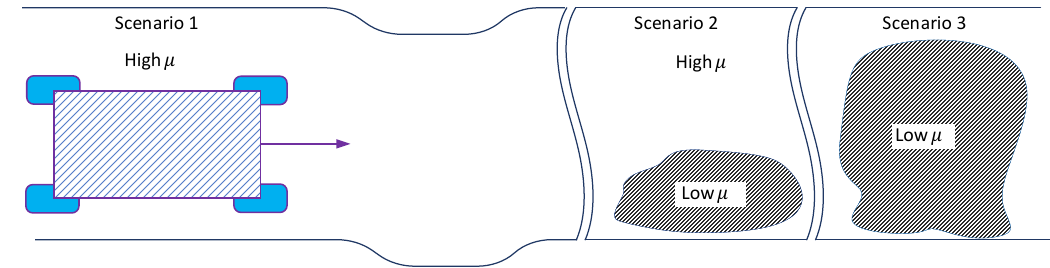
Figure 10. Scenarios for HIL Simulation System Evaluation.